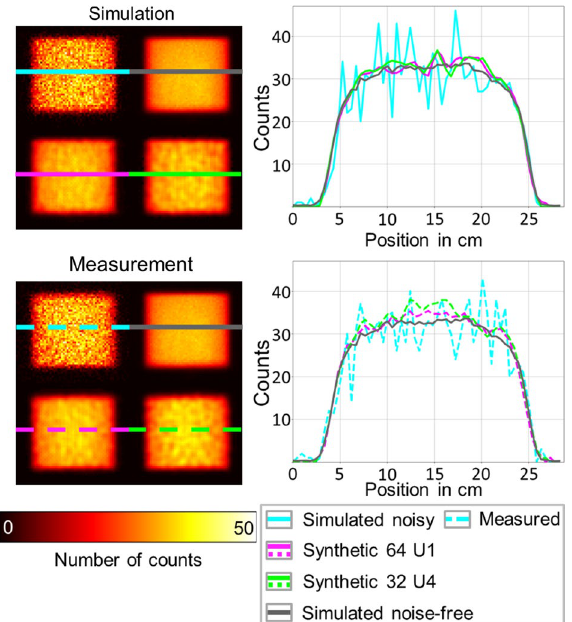
Fig. 7 Comparison of measured and simulated projections of a filled Jaszczak cylinder with synthetic projections. The synthetic projections were generated by u‑nets U1 (magenta) and U4 (green), respectively. The right graphs each show the cross section through the projections along the colored lines, where the solid curves represent the simulations and the dashed curves represent the measurements. The cross section through the noise‑free (simulated) projection is also shown for both the measured and the simulated projections (solid gray curve)